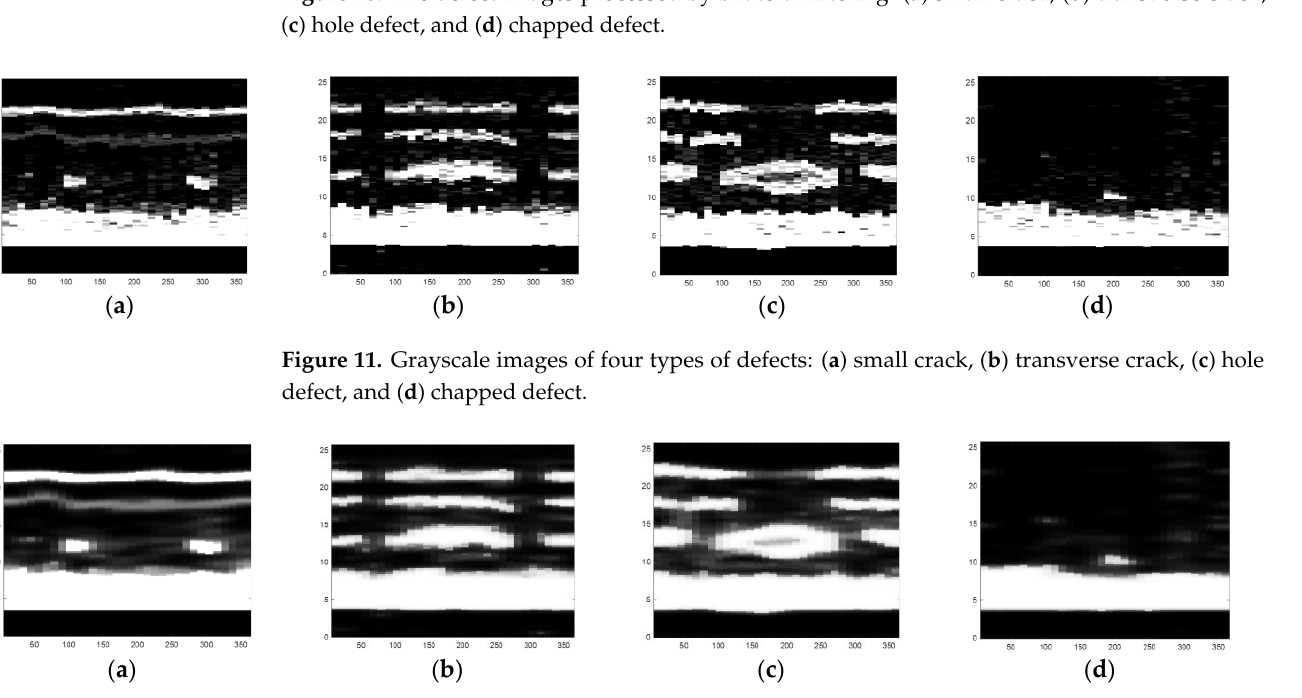
Figure 12. The defect images processed by the combination of Laplacian operator and bilateral filtering: ( a ) small crack, ( b ) transverse crack, ( c ) hole defect, and ( d ) chapped defect.